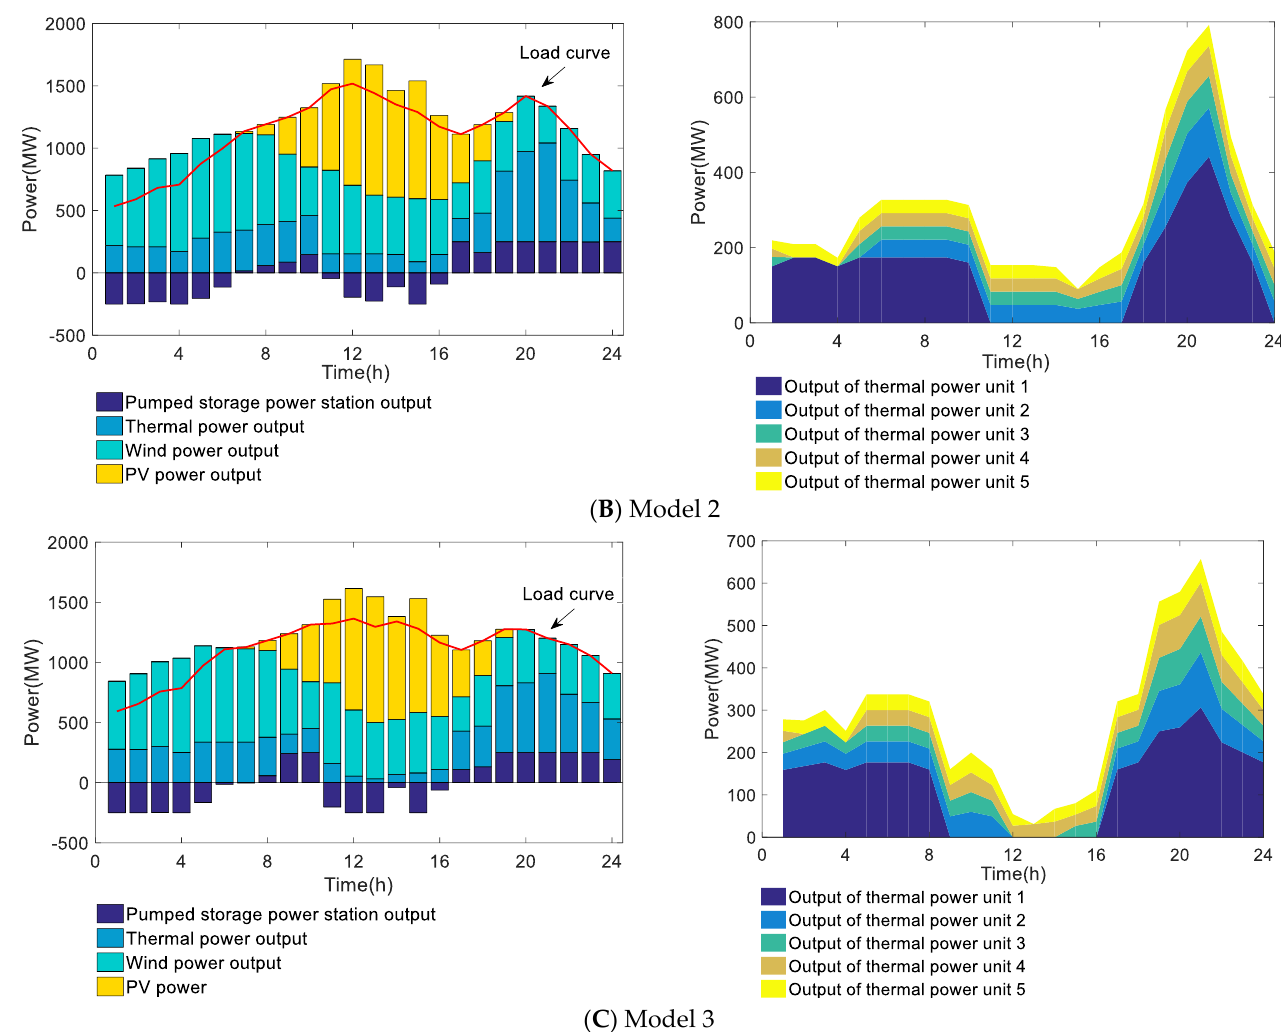
Figure 5. Optimization results under three scheduling models.